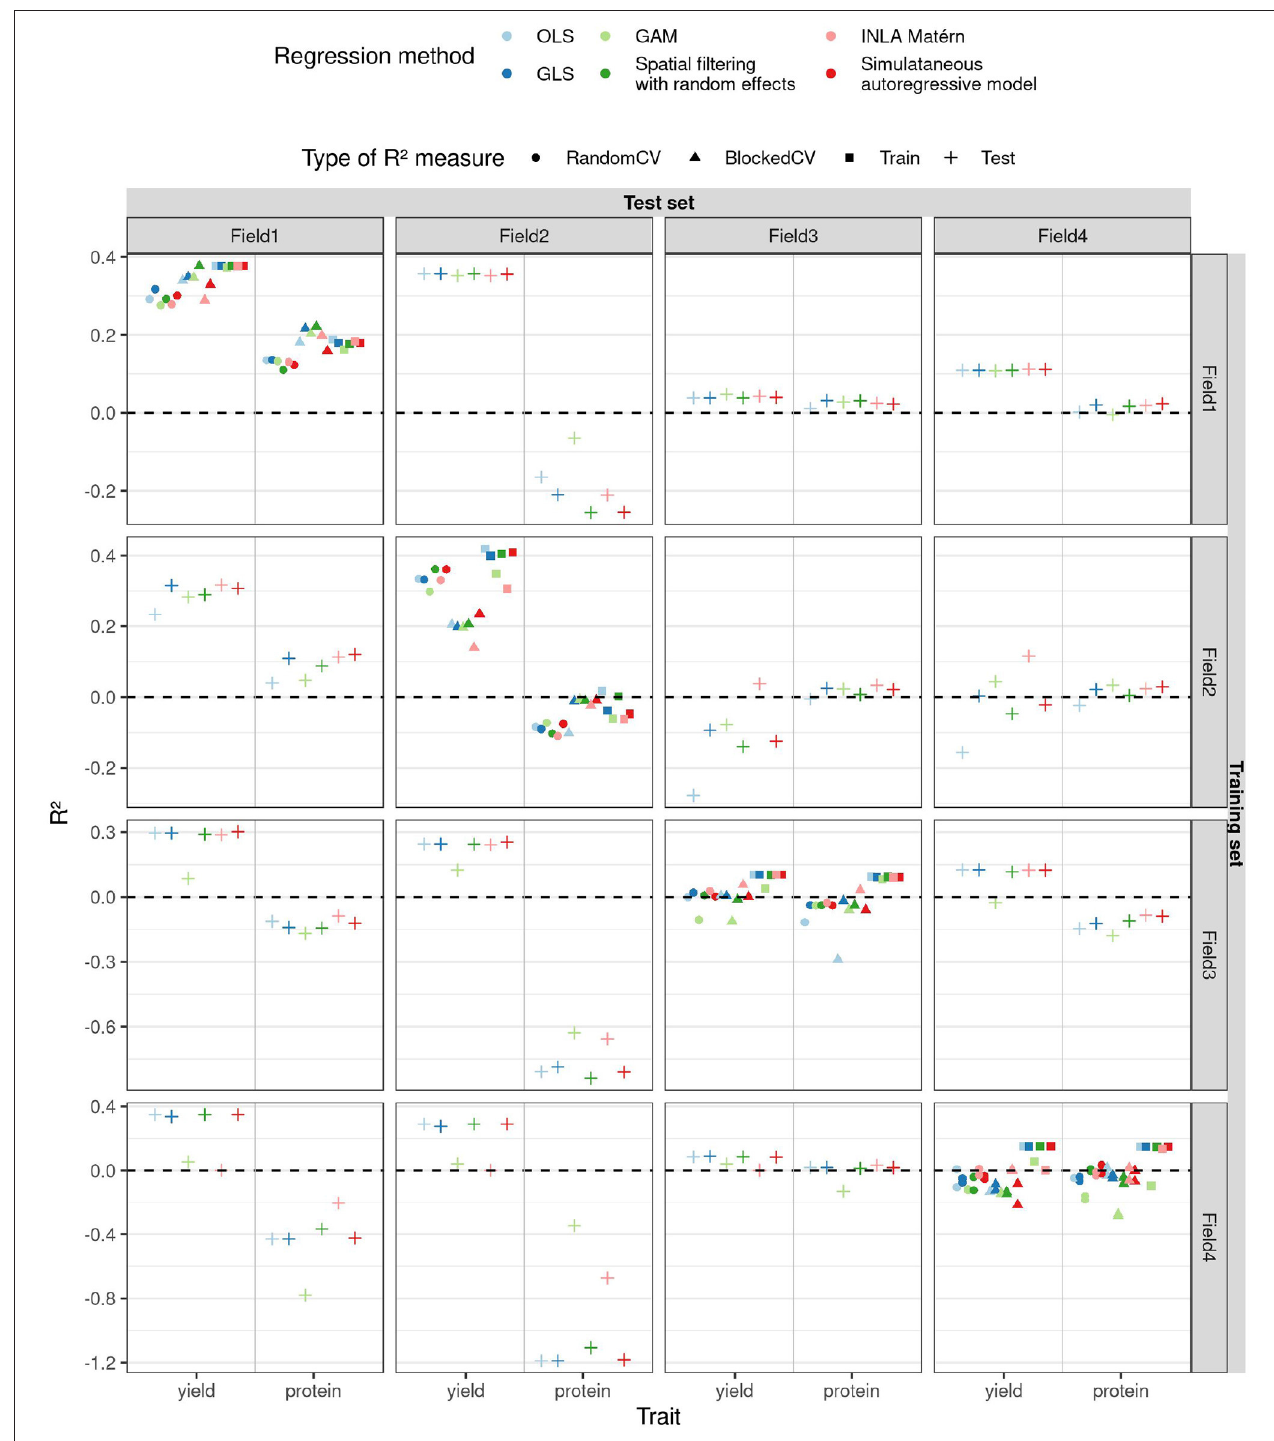
FIGURE 7 | R 2 (y-axis) estimated in different ways (shapes) for the two traits (x-axis) as a function of different training and test fields (rows and columns, respectively) and regression methods (color) for the case study on winter wheat.